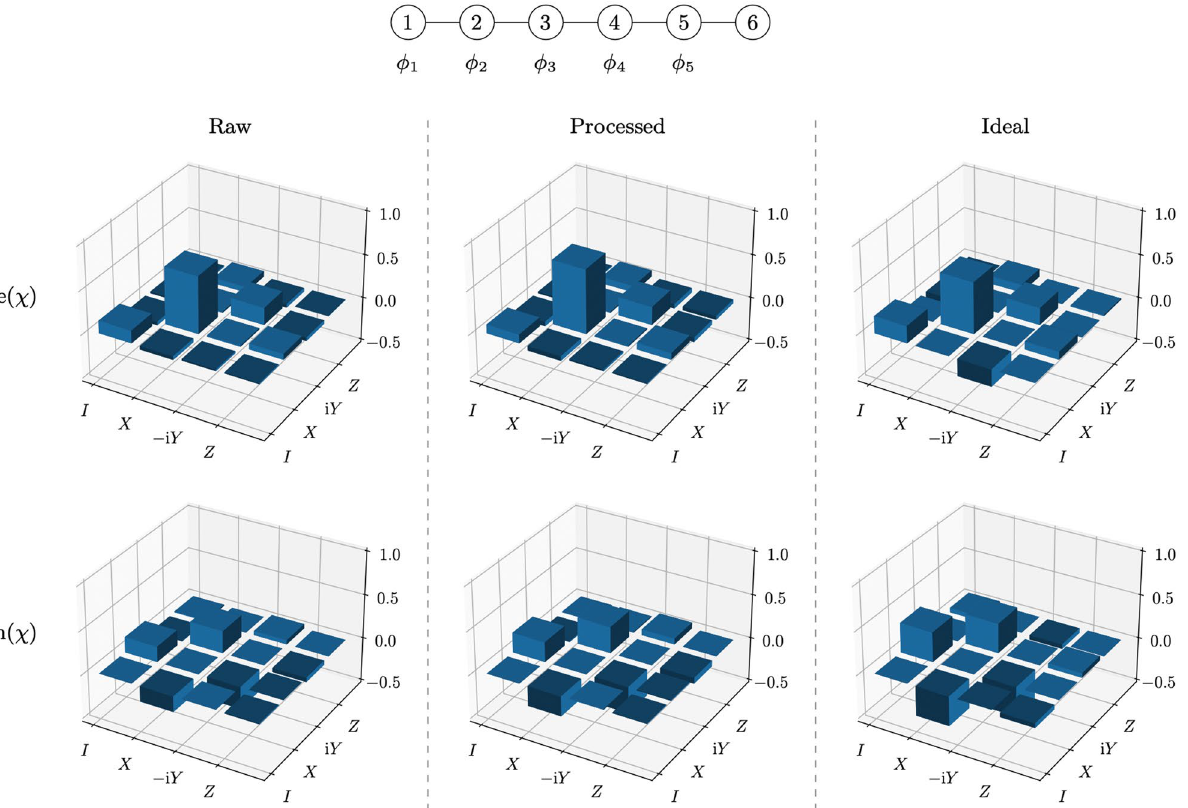
Figure 4. Example of channel tomography results for the random unitary that agreed most with the ideal 11001 with the exact 3-design on the ibmq_toronto quantum case generated for measurement outcome m = processor. The diagram at the top shows the entangled 6-qubit cluster state with the measurements performed on each qubit. The χ matrix obtained without quantum readout error mitigation is shown on the left, the χ matrix obtained with quantum readout error mitigation is shown in the middle and the ideal χ matrix is shown on the right. The real part of each matrix is shown above and the imaginary part of each matrix is shown